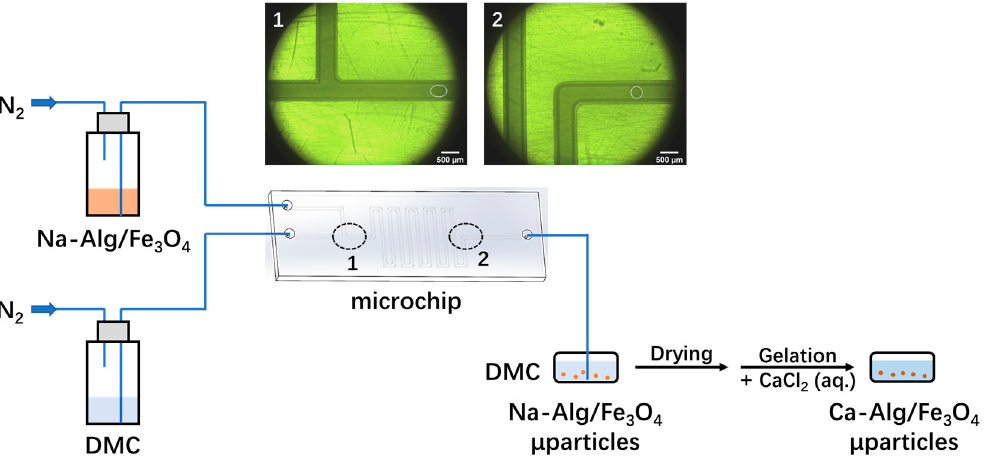
Figure 1. Schematic illustration of the preparation of Ca-Alg/Fe 3 O 4 micromotors, with optical microscopic images of a droplet (outlined in white) generated right after the T-junction at Position 1 (insert microscopic image 1) and a droplet near the outlet of microchip at Position 2 (insert microscopic image 2).